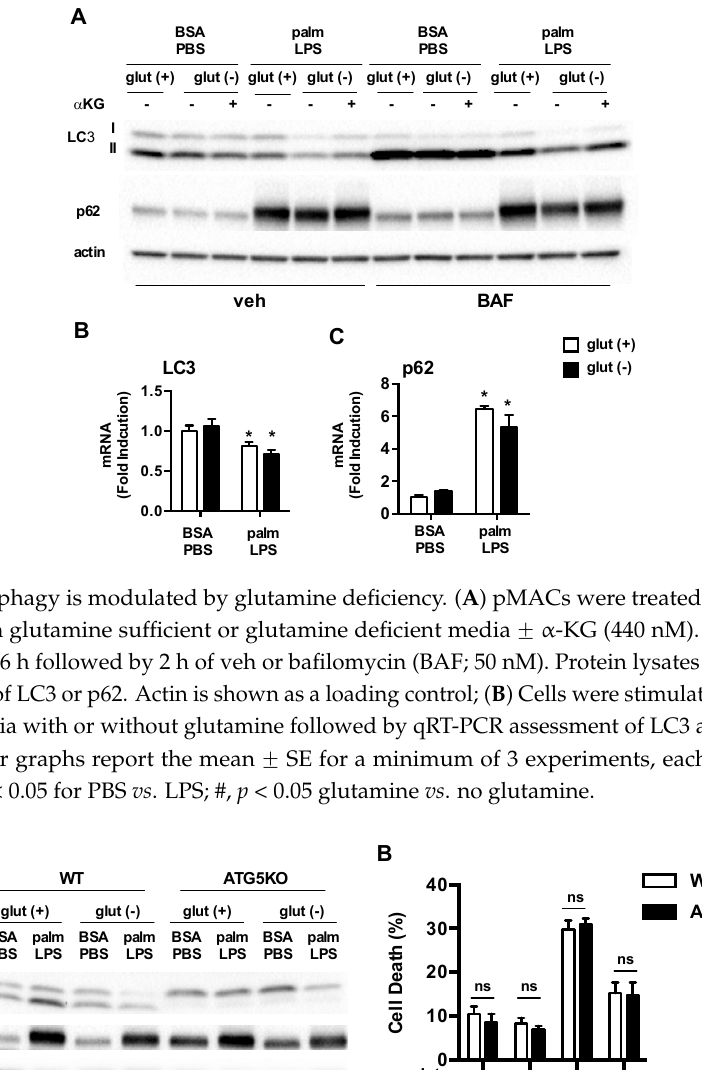
h l l ea t C e D ll C e